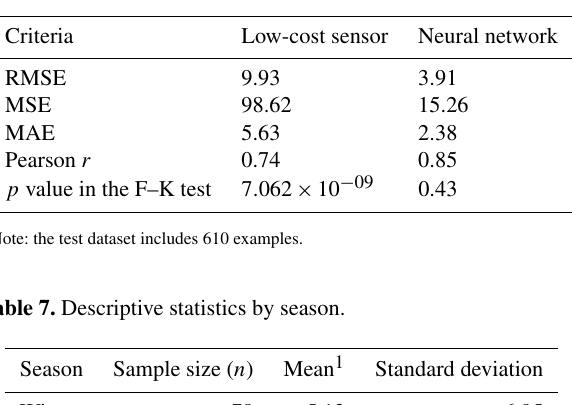
Table 4. Table 4: calibration results by XGBoost using the test dataset.